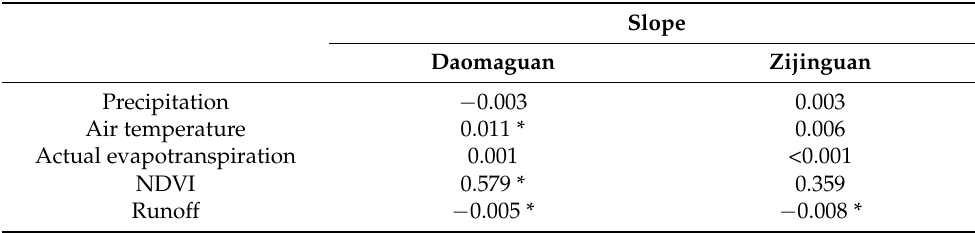
Table 1. Results of MK trend analysis for precipitation, air temperature, actual evapotranspiration, NDVI and runoff. The “*” represents the significant trend.